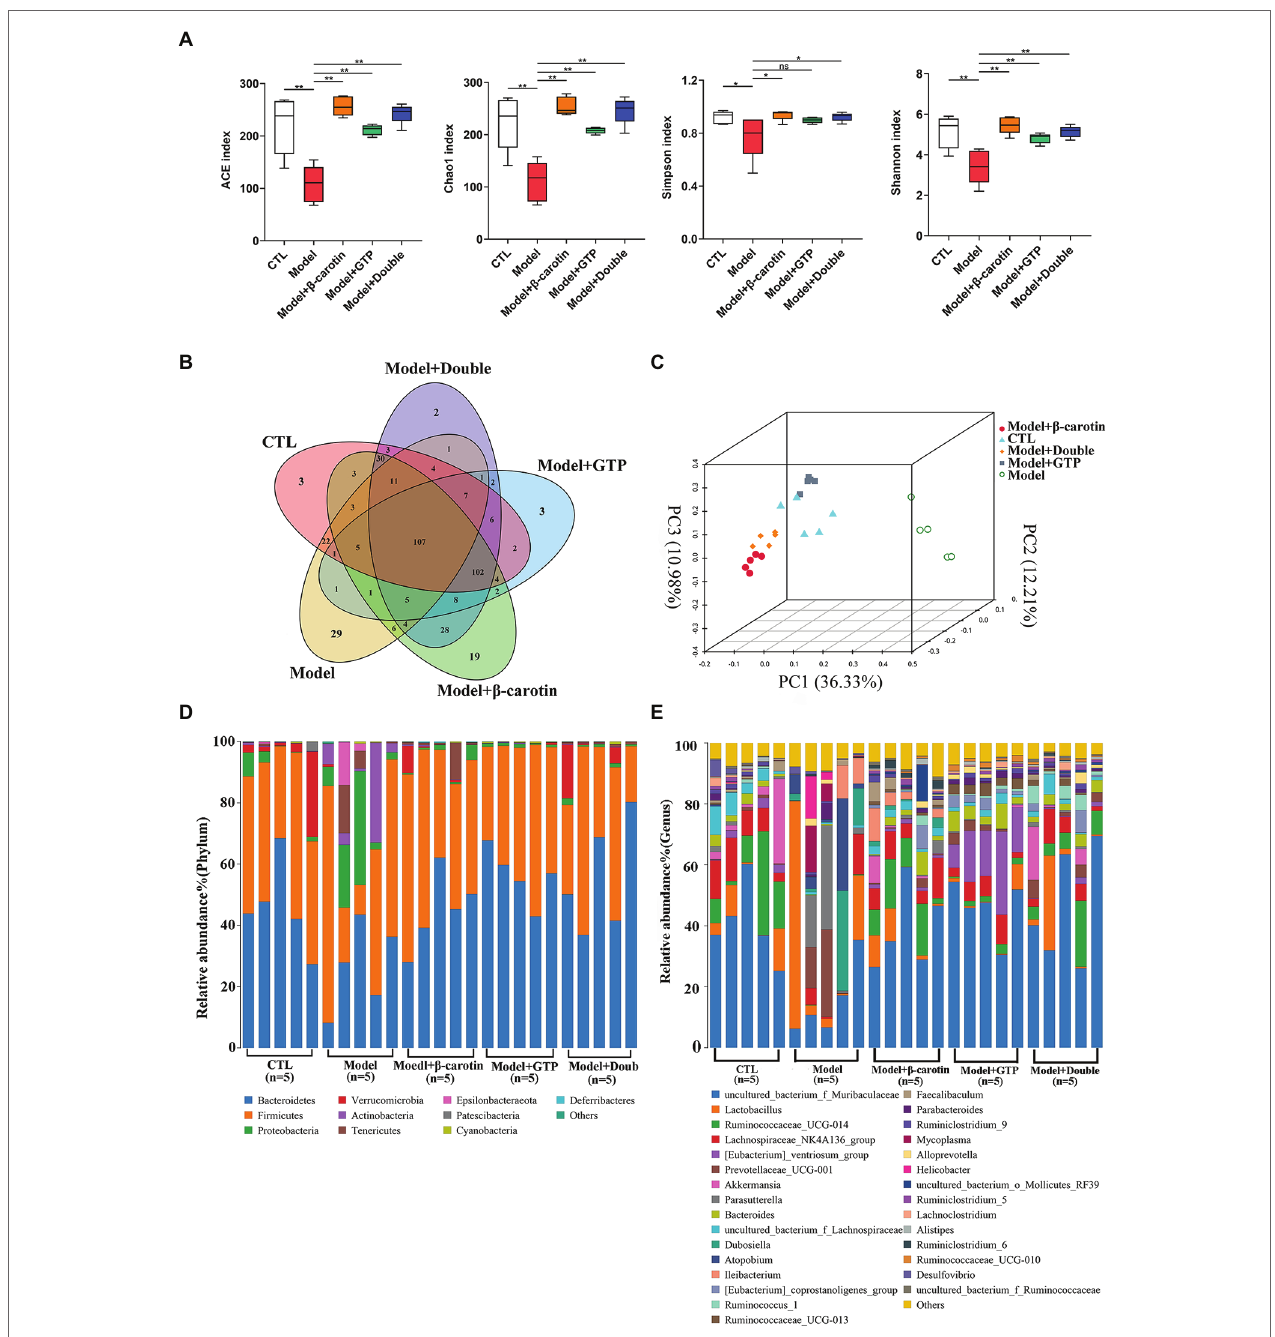
FIGURE 4 | Alterations in gut microbiota among five groups of mice. (A) Alpha diversity analysis. (B) Venn diagram of operational taxonomic units (OTUs). (C) Principal coordinate analysis (PCoA) of the gut microbiome. (D) Composition of the gut microbiota at the phylum level among the five groups of mice. (E) Composition of the gut microbiota at the genus level among the five groups of mice. * p < 0.05, ** p < 0.01, and “ns” indicates no statistical